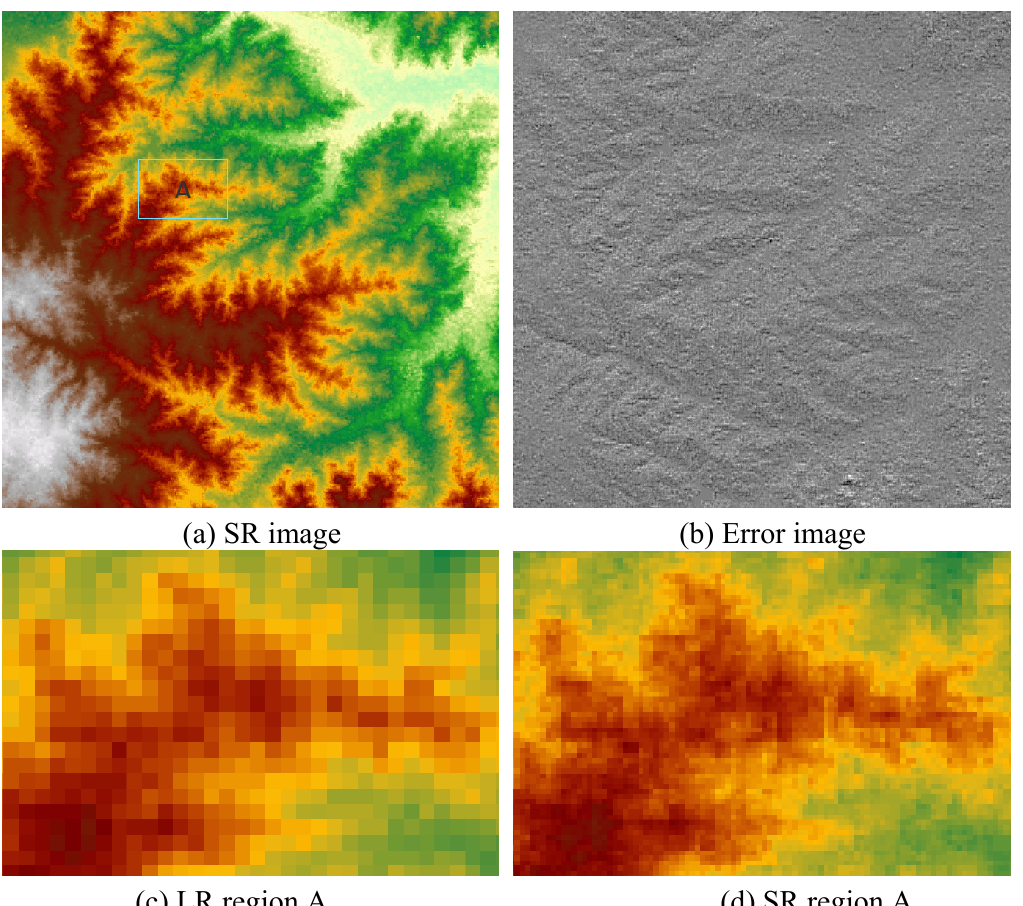
Figure 8. Super-resolution reconstruction of SRTM